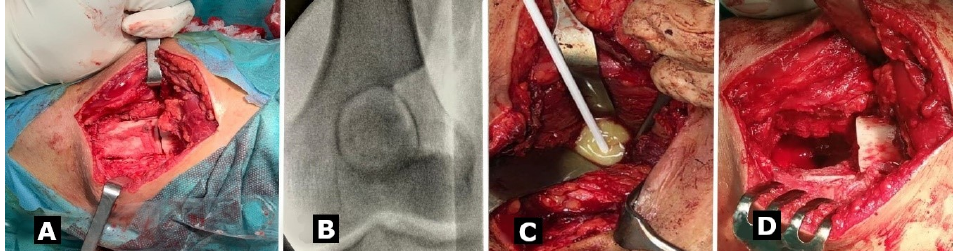
Figure 2 . ( A ) Anterolateral approach with bone fenestration of the distal femur to access the cavity of the abscess. ( B ) Bone window placed under fluoroscopy control. ( C ) Intraoperative culture test was harvested. ( D ) Intraoperative aspect after physicochemical debridement using pressure lavage and antiseptic solutions.